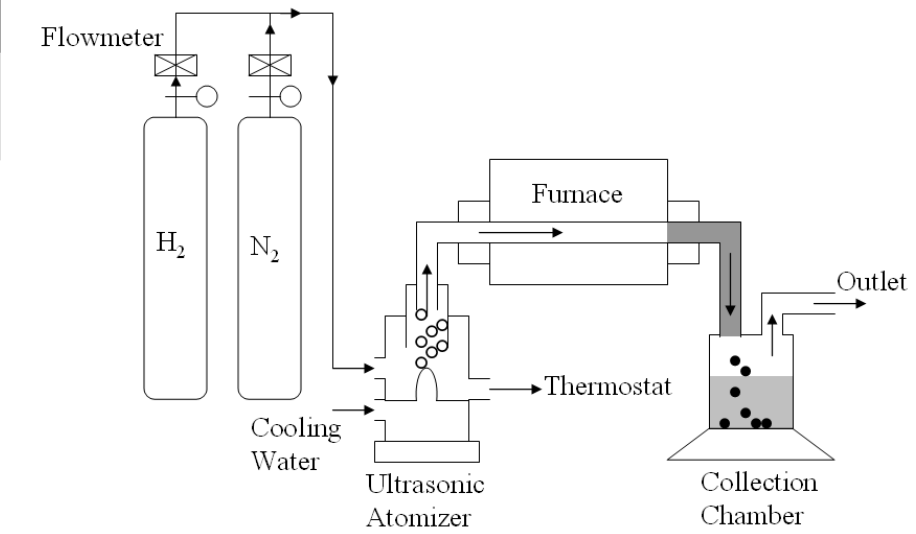
Figure 3 – Schematic drawing of the experimental apparatus for the synthesis of gold nanoparticles from a gold-chloride